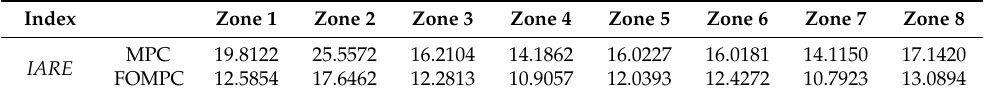
Table 4. Indices for IARE in the reference tracking experiment based on multiple lighting control.